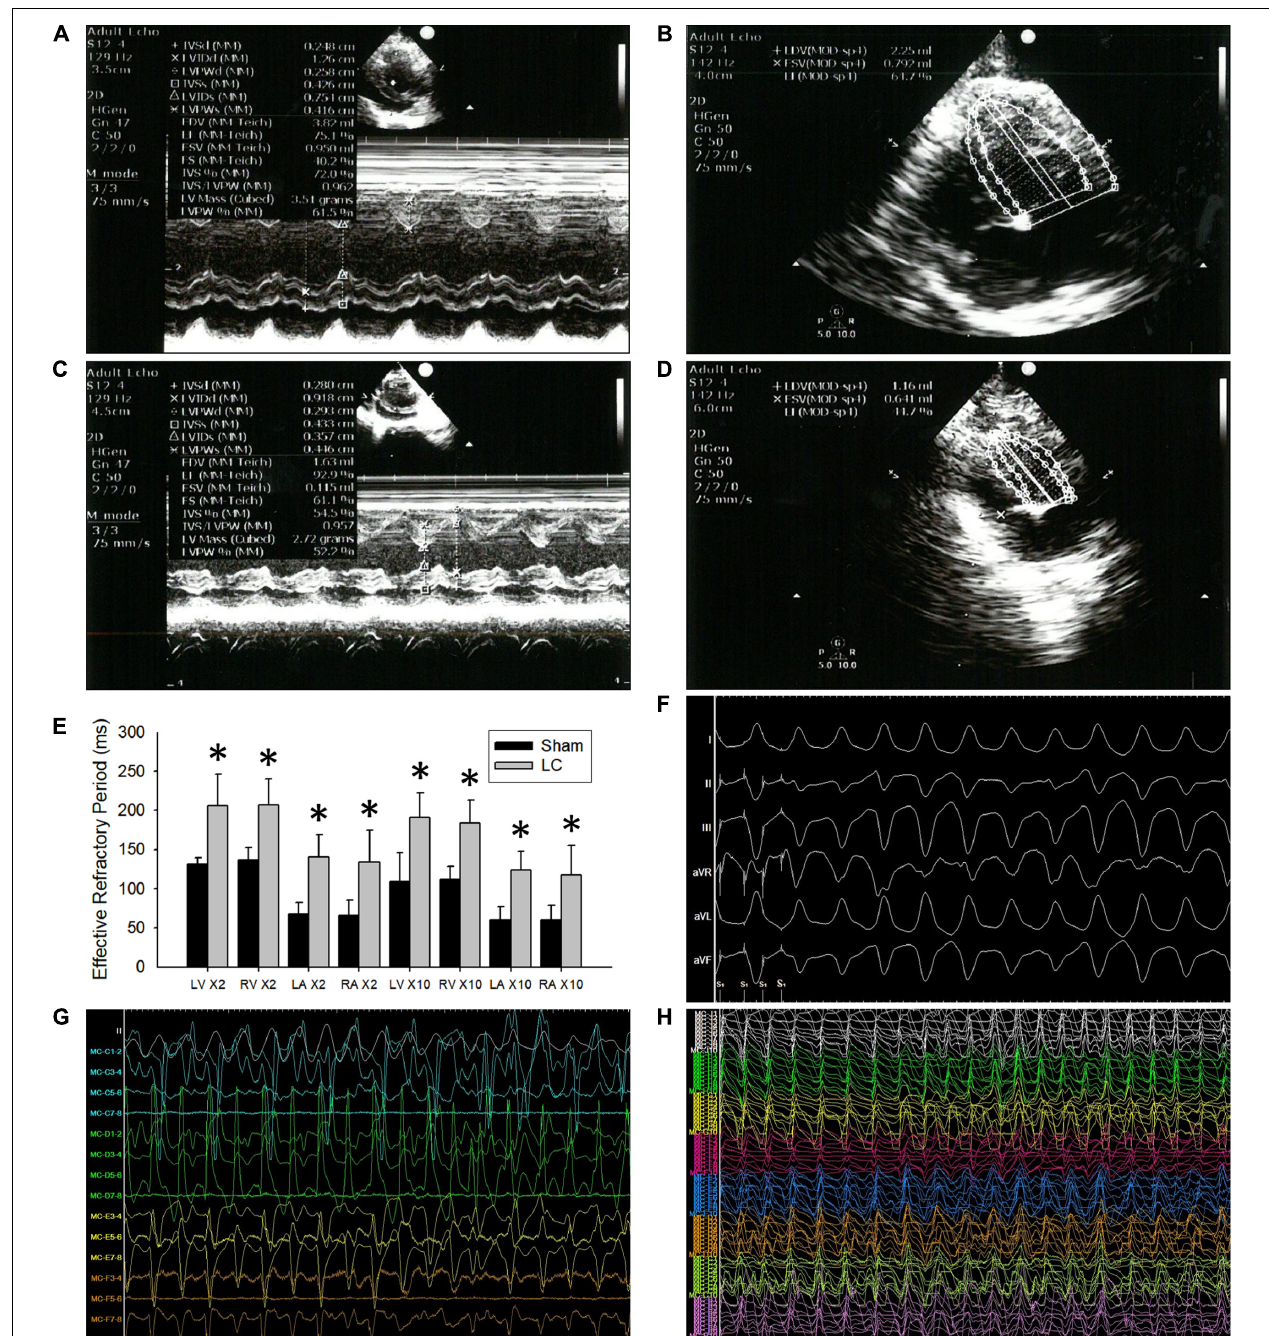
FIGURE 1 | The echocardiograms and cardiac electrophysiological study. (A,B) Representative echocardiogram images in the sham group. (C,D) Representative echocardiogram images in the liver cirrhosis (LC) group. (E) Comparison of 2 and 10 times the pacing threshold for effective refractory period (ERP) (ms) in all the cardiac chambers between the sham and LC group. (F) A representative ECG of ventricular arrhythmia (VA) induced by VA inducibility test in the LC group. (G) A representative bipolar electrogram of the ventricle during VA in the LC group. (H) A representative unipolar electrogram of the ventricle during VA in the LC group. * p < 0.01, compared with the sham group.